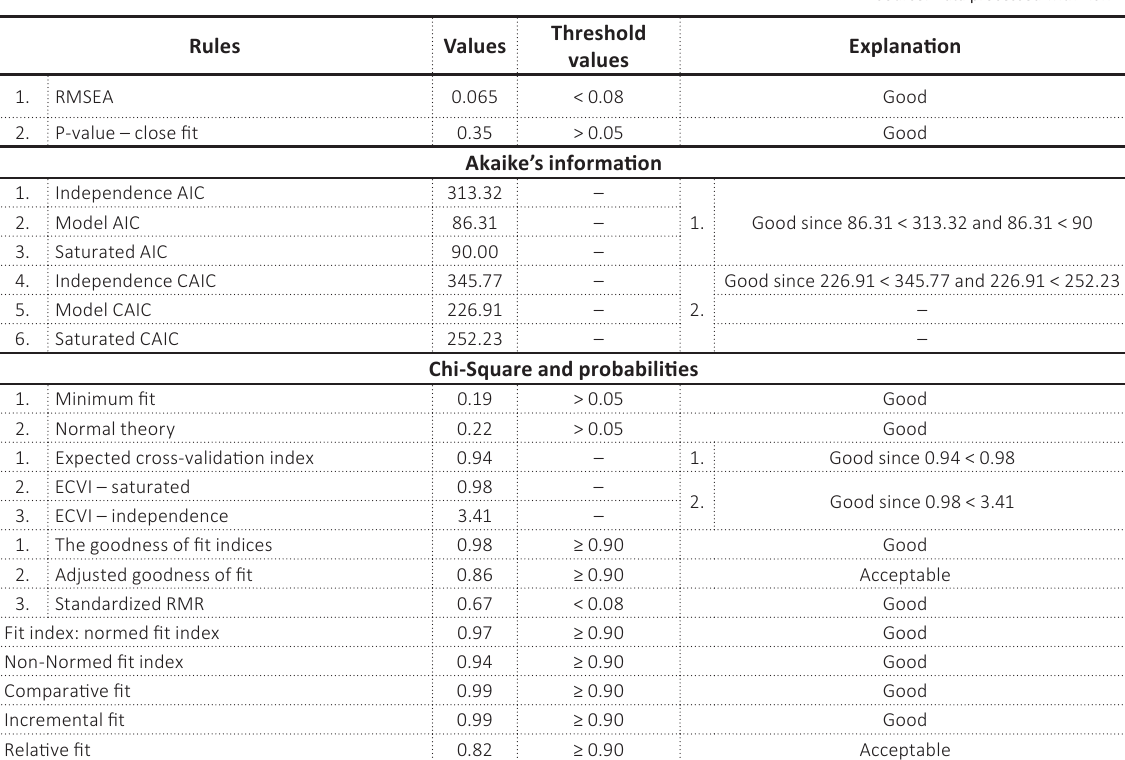
Table 4. Goodness of fit